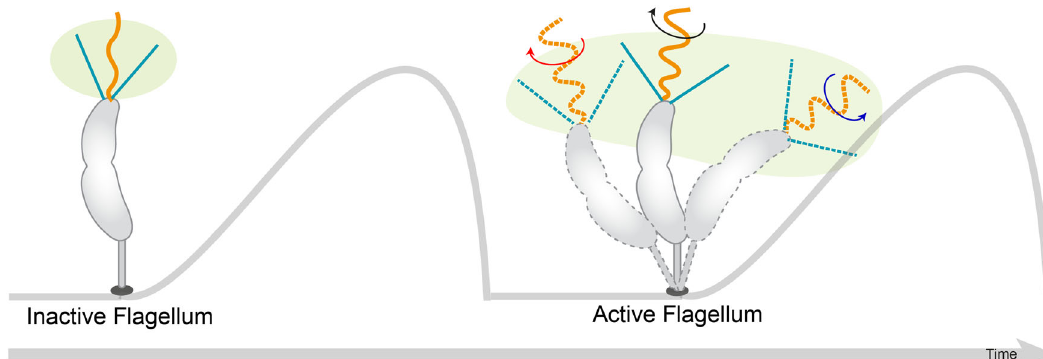
Fig. 5 Surface sampling area of the predivisional daughter cell before (left) and during (right) rotation of the fl agellum. Because the rotating fl agellum can bend the predivisional cell, the surface sampling area is increased when an active fl agellum is present (surface sampling is indicated in